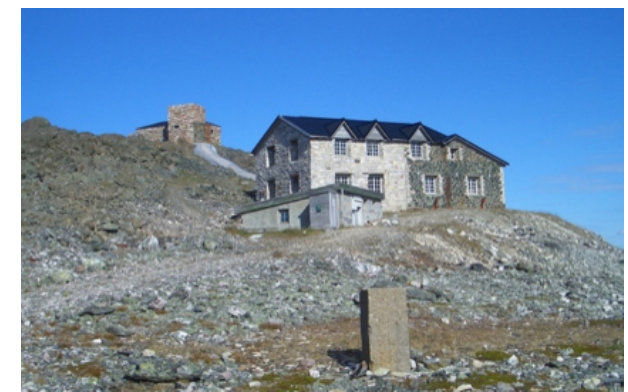
Figure 9. The Haldde Observatory in August 2018 (photo: As- geir Brekke, 2018).